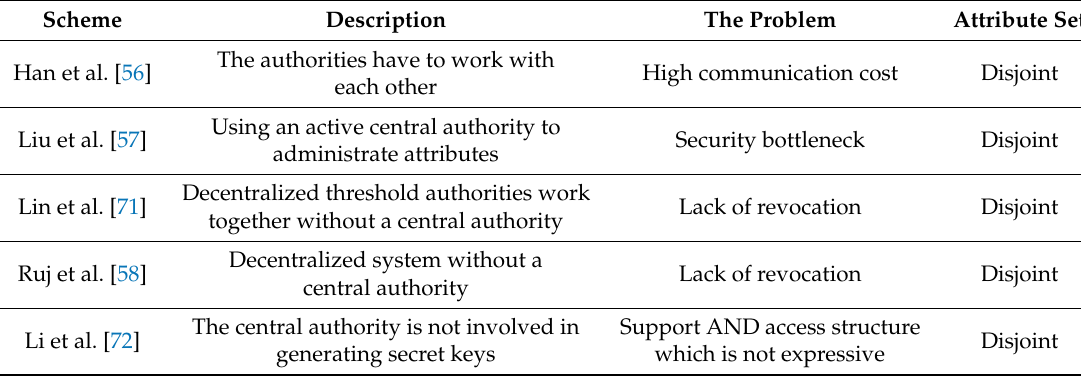
Table 4. Summary of main existing systems and their